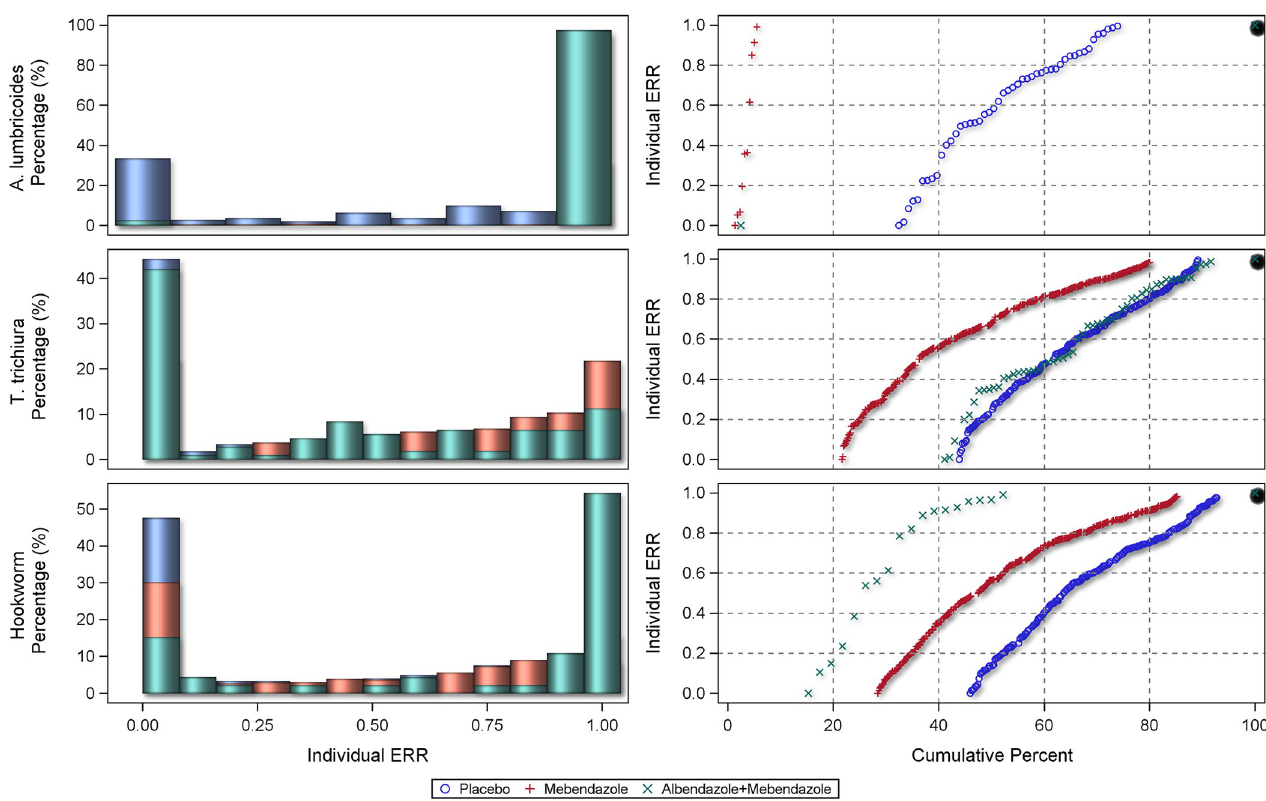
Fig 9. Distribution of individual responses in studies of 14–21 days follow-up for Ascaris lumbricoides , Trichuris trichiura and hookworm for mebendazole and mebendazole combinations. The right-hand plots show the proportions of people at a given ERR with colours related to placebo or a drug. The left-hand plots show cumulative distribution of ERR in people treated with a drug from 0 to 100%.